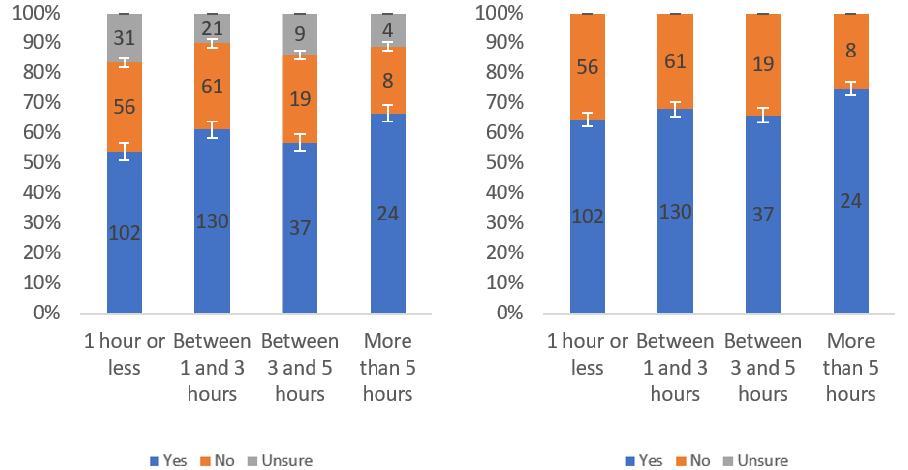
Figure A18. Responses regarding label helpfulness by internet usage level including ( left ) and excluding ( right ) unsure responses.